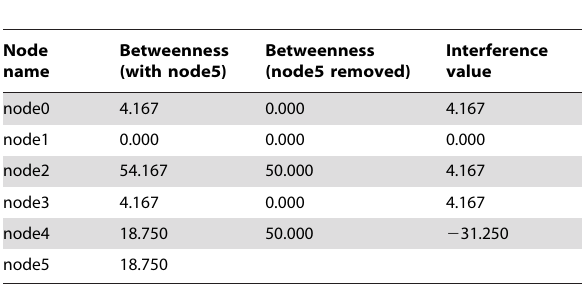
Table 1. Interference values of the network in figure 1, expressed as